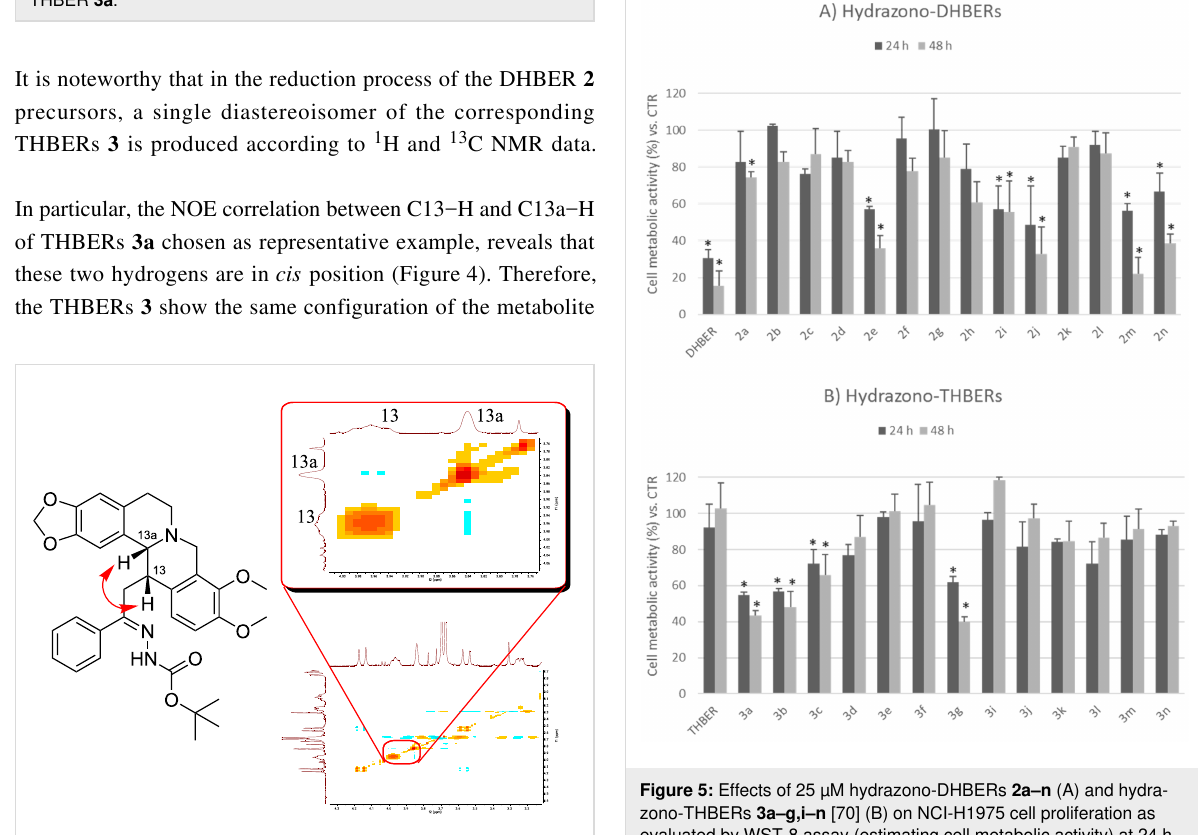
Figure 3: Comparison between 1 H NMR spectra of DHBER 2a and of THBER 3a .